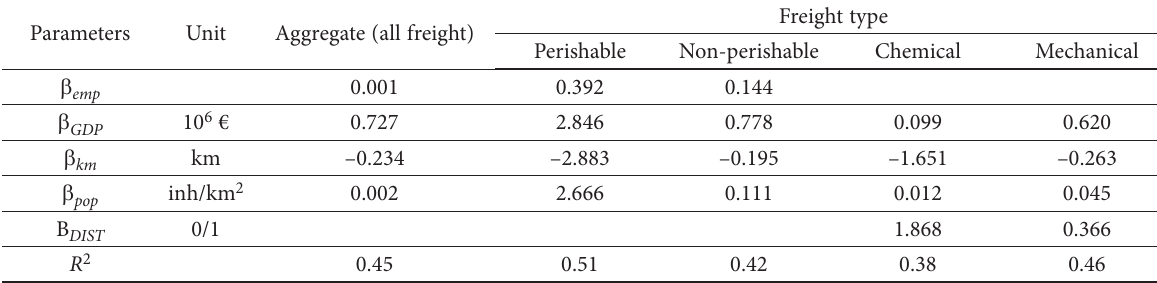
Table 8. Distribution model for export: calibration